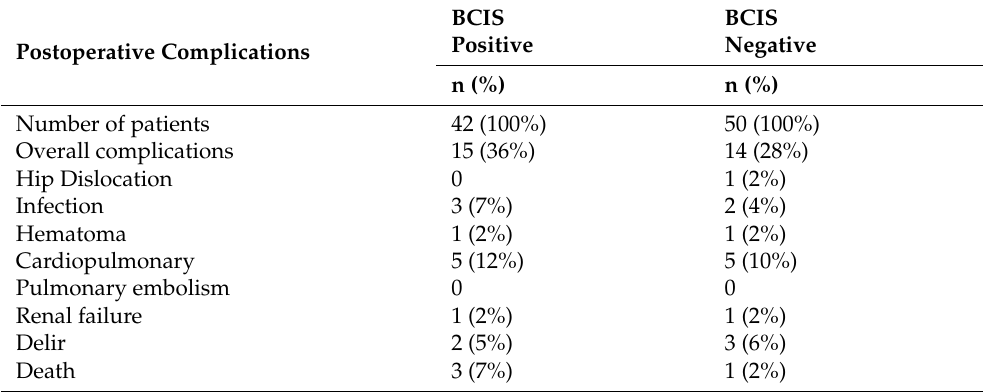
Table 4. Postoperative Complications in BCIS positive and negative